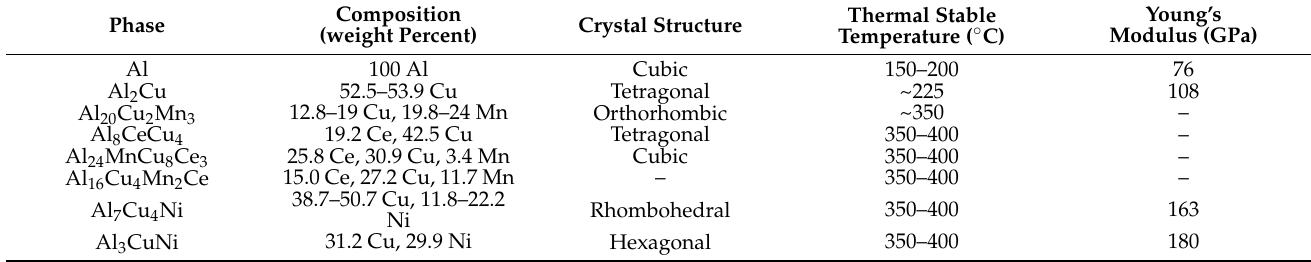
Table 4. Summary of the physical parameters of phases in the alloys